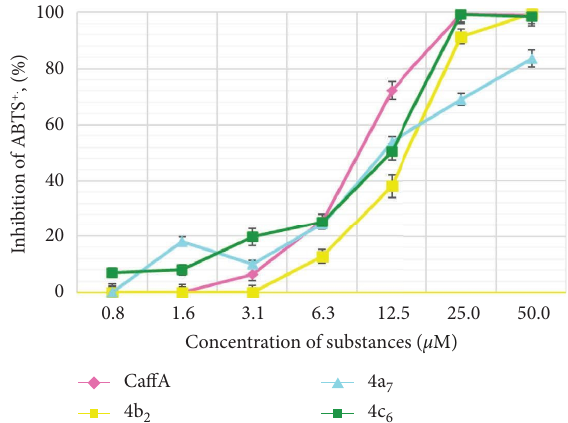
Figure 2: ABTS radicals inhibition (%) of the tested compounds, applied in diferent concentrations (from 0.8 to 50 µ M).